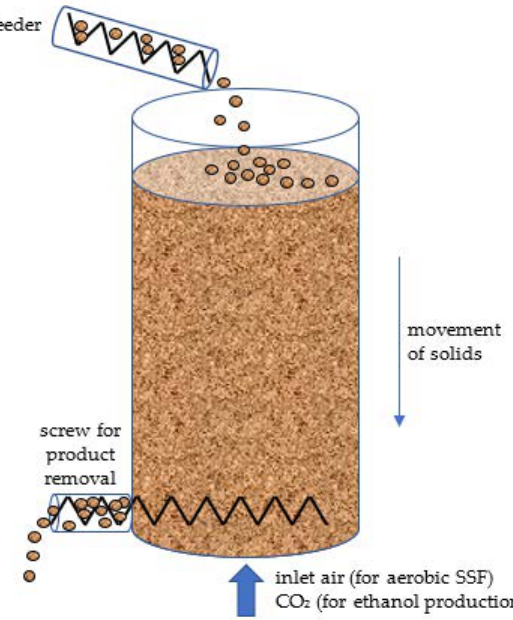
Figure 5. Principles of operation of the continuous packed-bed reactor of Chen et al.